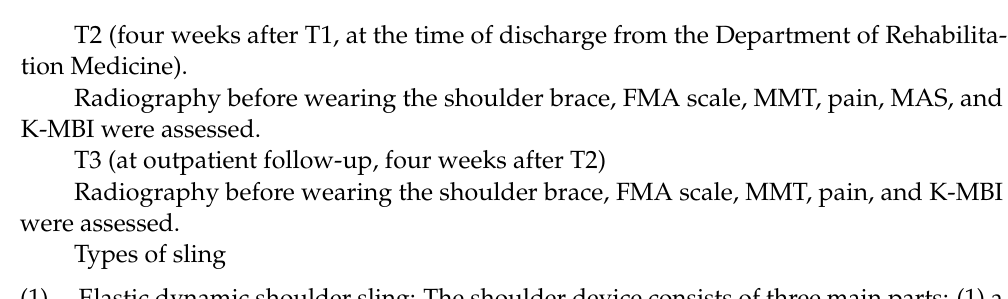
Figure 3. Timeline of assessment and follow up of enrolled